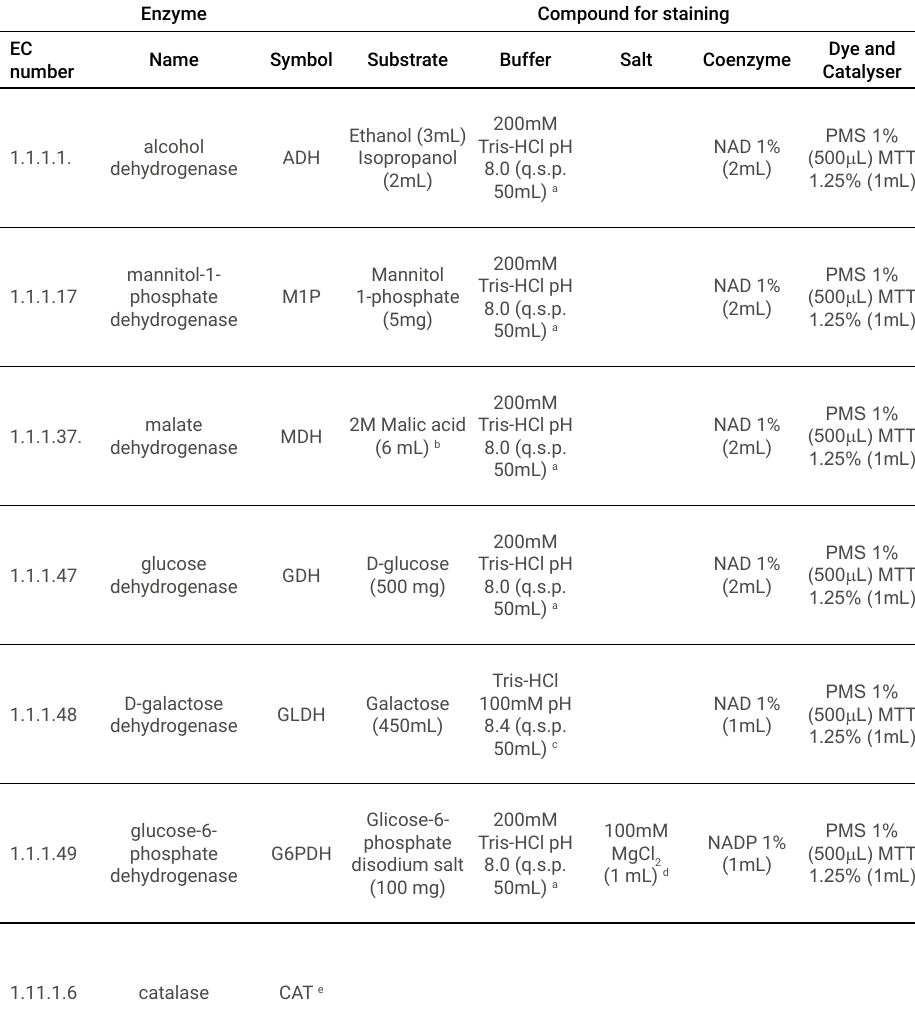
Table 1. Systems and solutions utilized for the MLEE analyses of the S. aureus metabolic enzymes.